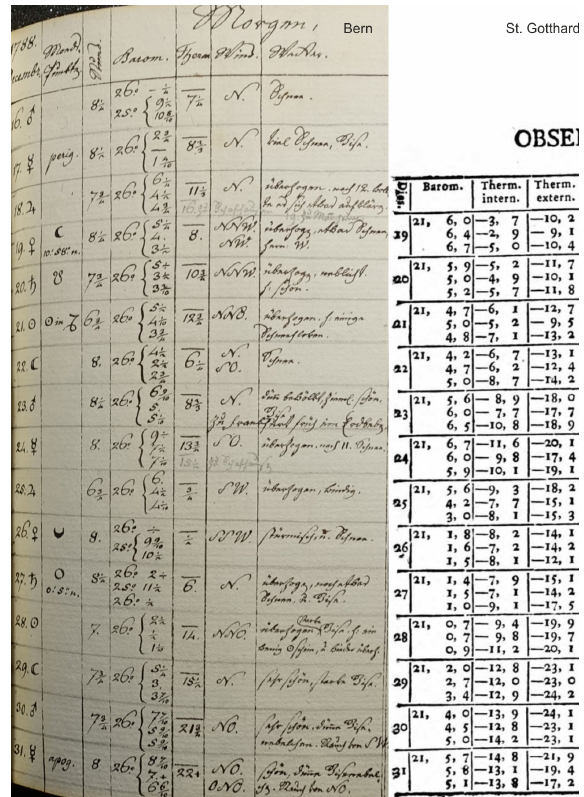
Figure 5. Excerpts of data sheets from Bern and St. Gotthard Pass for the second half of December 1788. For St. Gotthard Pass, the wind was noted as “NW” for every single day; not shown (Burger- bibliothek of Berne: Mss.h.h.XX.5.2; LMU Munich library: 0001/4